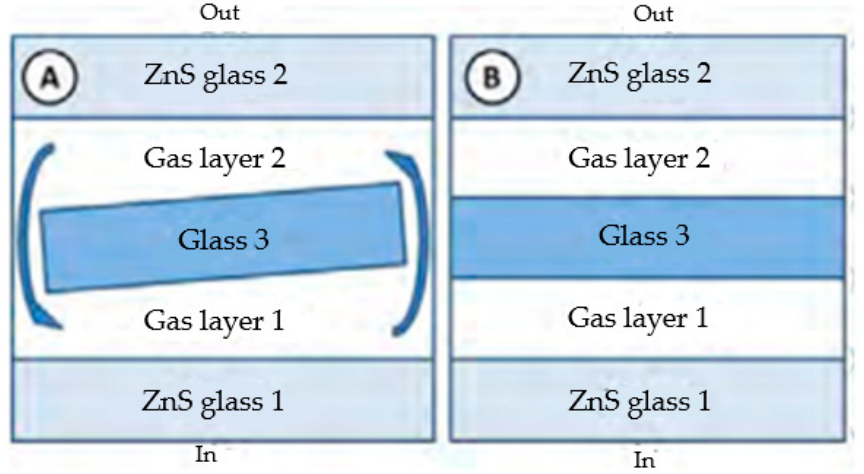
Figure 8. Different skylight configurations Ⓐ cooling mode Ⓑ insulating mode [20]. When the skylight is in its cooling mode, heat from the below room is transferred to the gas via the lower window (ZnS glass 1) via radiation, conduction and natural convection.